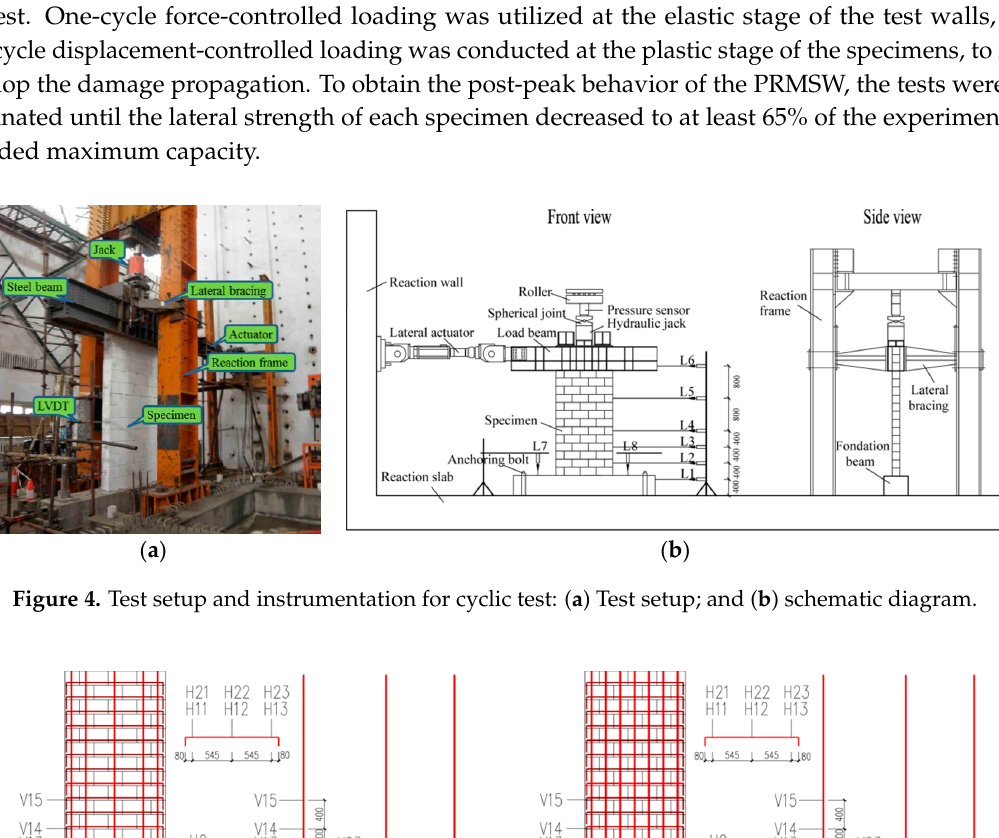
Figure 3. Construction procedures for the prefabricated reinforced masonry shear wall (PRMSW): ( a ) Construction of the foundation beam and the vertical rebar; ( b ) lifting and assembling the